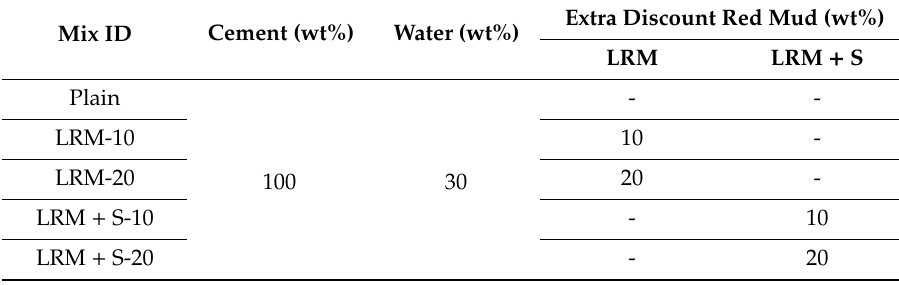
Table 4. Mixture